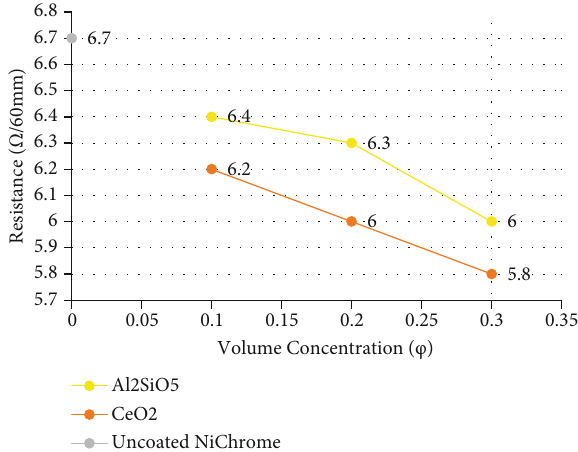
Figure 18: In fl uence of coating over Ni-Chrome wire on resistance of